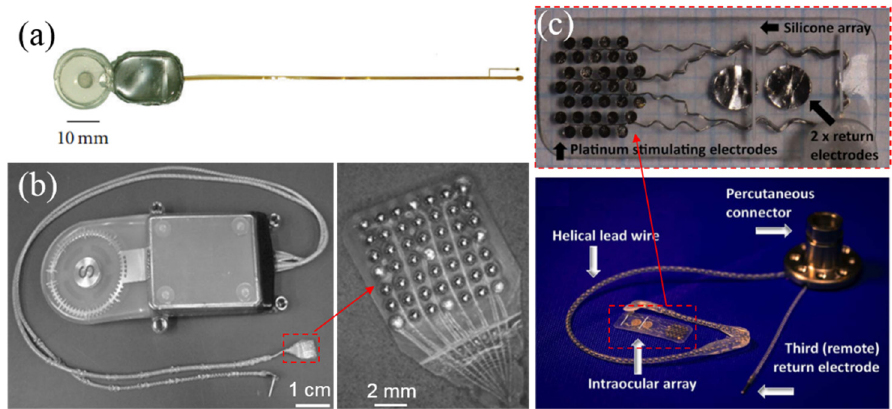
Figure 8. ( a ) A suprechoroidal implant for transretinal stimulation [70]; ( b ) the supra-choroidal- transretinal stimulation (STS) implant including the suprachoroidal stimulating array and the remote return electrode [77] ; ( c ) the Bionic Vision Australia (BVA) implant with 1 remote return and 2 other